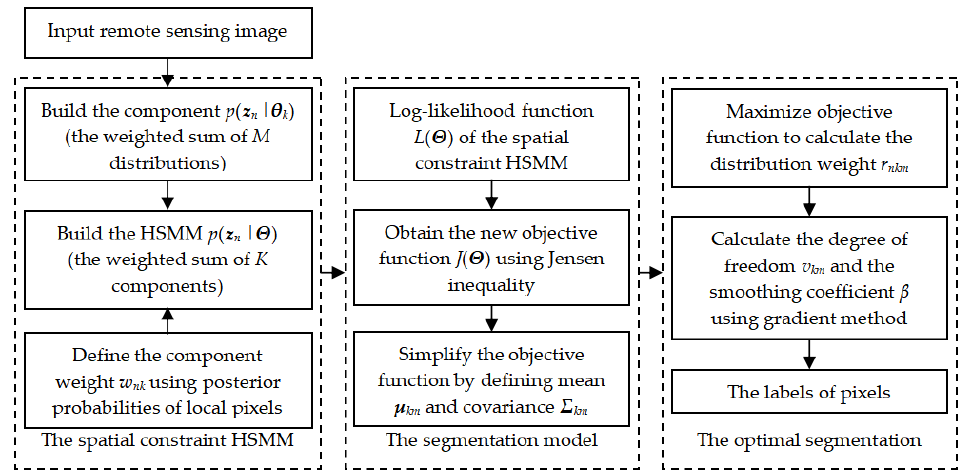
Figure 1. The schematic diagram of the segmentation algorithm using the spatial constraint HSMM.